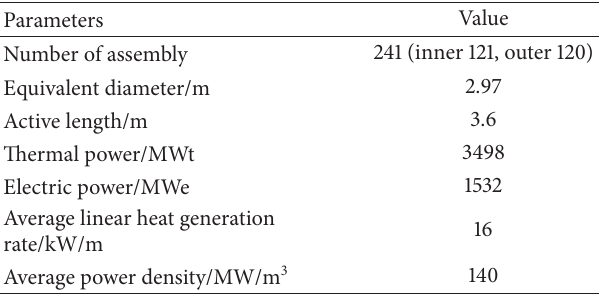
Table 1: SCFR core design parameters.